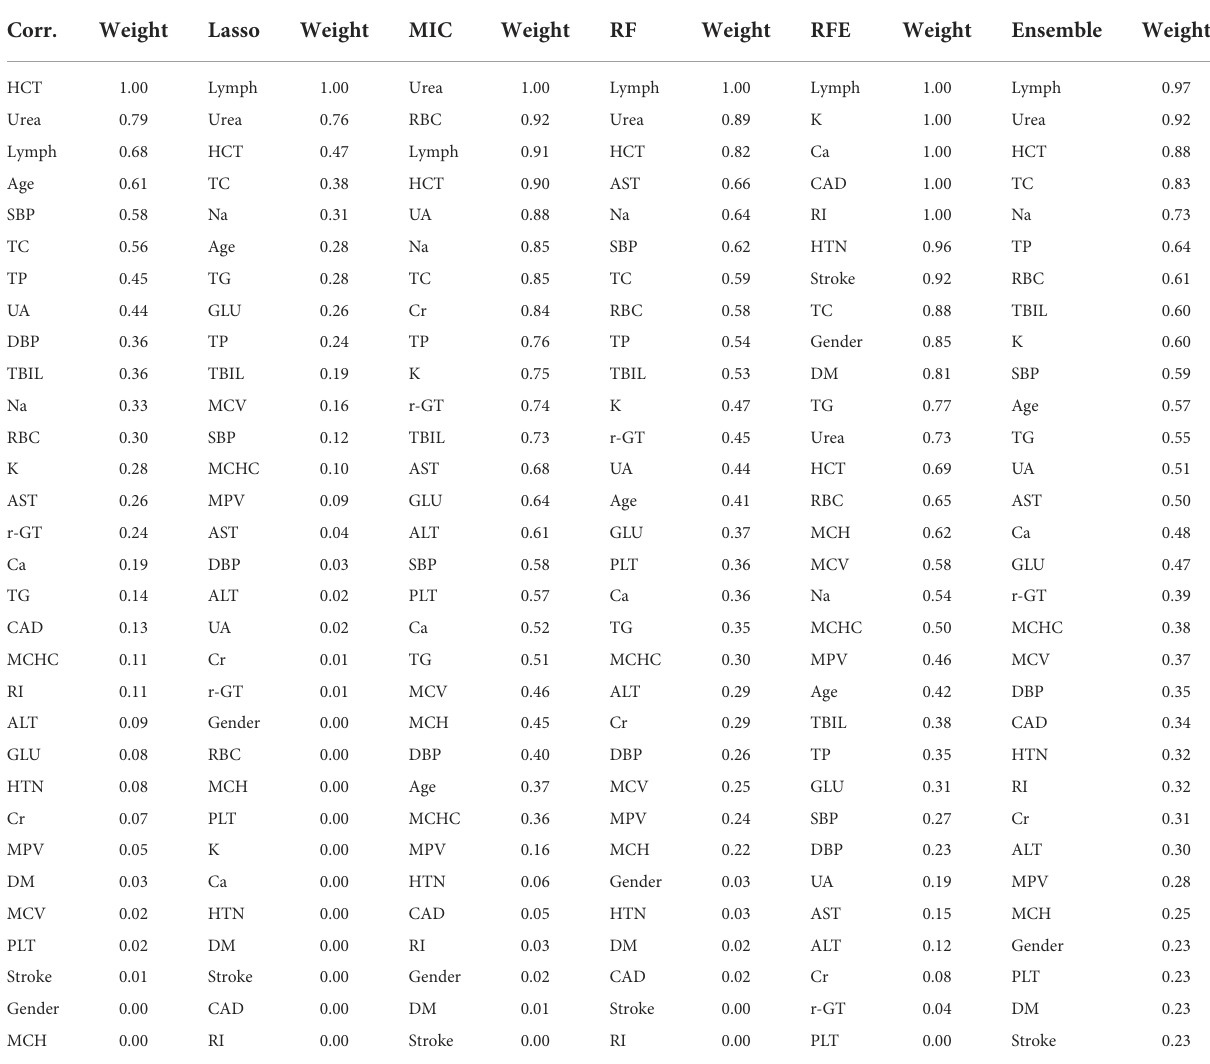
TABLE 2 Results of ML models for feature selection.